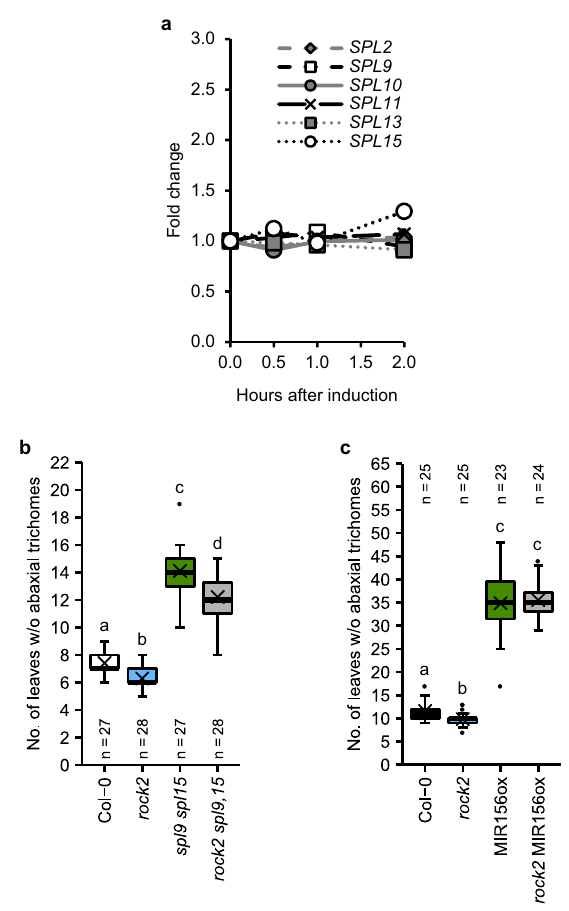
Fig. 4 SPLs are involved in the cytokinin-dependent regulation of vegetative phase change. a SPL expression kinetics in 10-day-old SD- grown MIM156 seedlings after treatment with 1 µ M BA. Transcript levels were determined by qRT-PCR. Data were normalized to TAFII15 and PP2AA2 . Data displayed are expressed as mean ± SEM ( n = 6 biological replicates). Statistical analyses were performed using one-way ANOVA, post-hoc Dunnett ’ s test. No statistically signi fi cant differences were observed for any SPL gene, comparing each time point with time point 0 ( p < 0.05). b , c Number of leaves without abaxial trichomes in rock2 spl9 spl15 plants ( b ) and rock2 MIR156ox plants ( c ) grown in SD. In box plots, the center line represents the median value and the boundaries indicate the 25th percentile (upper) and the 75th percentile (lower). The X marks the mean value. Whiskers extend to the largest and smallest value, excluding outliers which are shown as dots. Letters indicate signi fi cant differences between the genotypes, as calculated by Kruskal – Wallis test ( q < 0.05). Exact p -values and q -values calculated for a – c are included in the Source Data fi